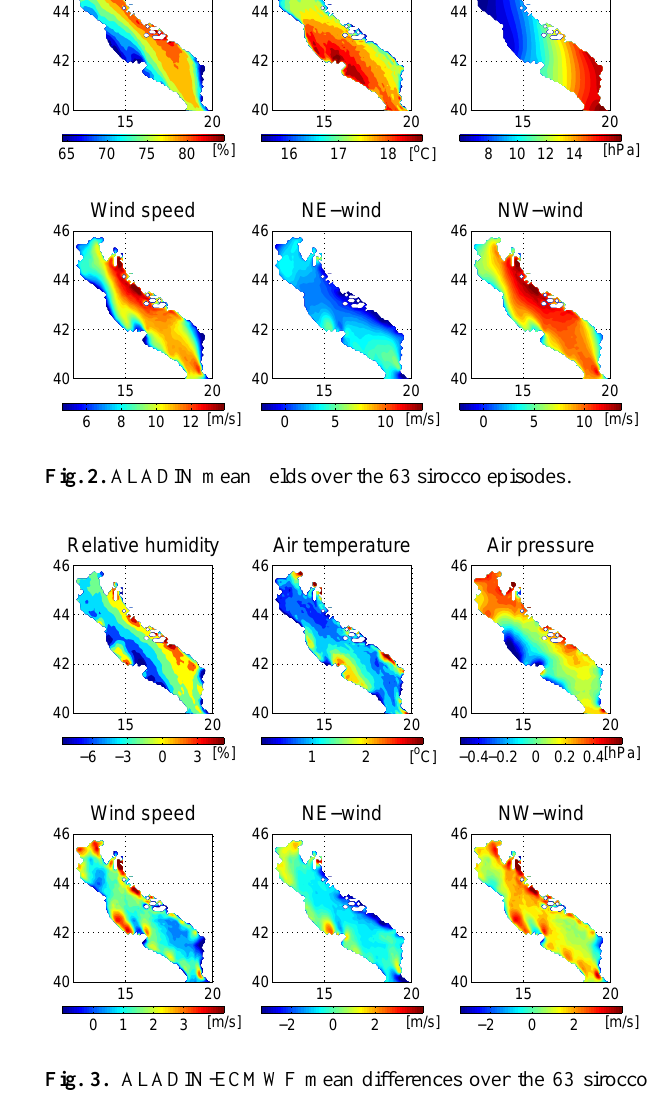
Fig. 3. ALADIN-ECMWF mean differences over the 63 sirocco